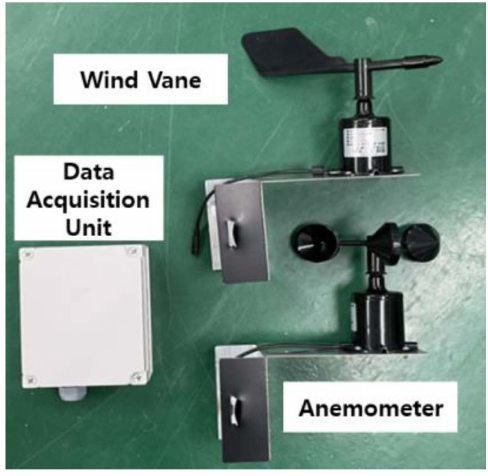
Figure 5. Anemometer configuration.